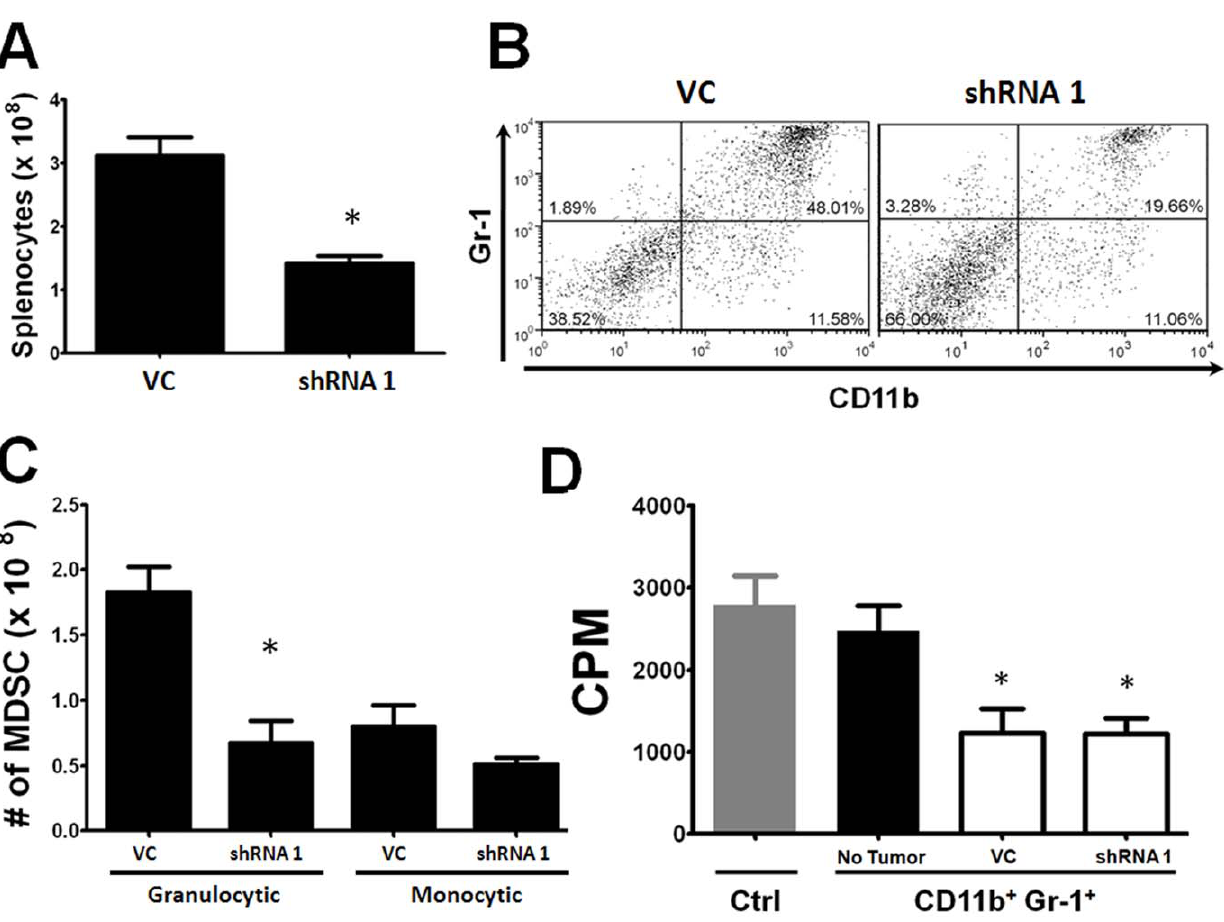
Figure 5. G-CSF knockdown reduces MDSC accumulation. ( A ) Splenocyte numbers were quantified from B6 mice with equivalent tumor burdens (800 – 1000 mm 3 ) of vector control and shRNA-1 AT-3 cells. Splenocyte numbers were significantly higher (* P , 0.004) in the control compared to the G-CSF knockdown cohort (n=5 mice each) . ( B ) Flow cytometric analysis of unfractionated splenocytes in panel A revealed a dramatic decrease in the percentage of CD11b + Gr-1 + cells in the control compared to the G-CSF knockdown cohort (n=5 mice each). ( C ) Splenocytes in panel B were evaluated for granulocytic and monocytic MDSC subsets based on additional staining with anti-Ly6G and Ly6C mAb. Absolute numbers of the MDSC subsets were then calculated using splenocyte data in panel A . G-CSF knockdown led to a significant decrease (* P , 0.02) in the granulocytic fraction (n=3 mice each). ( D ) CD11b + Gr-1 + cells isolated from mice in panel A were assayed for their ability to suppress T cell proliferation in a one-way MLR (1 of 2 separate experiments) (* P , 0.02 compared to the